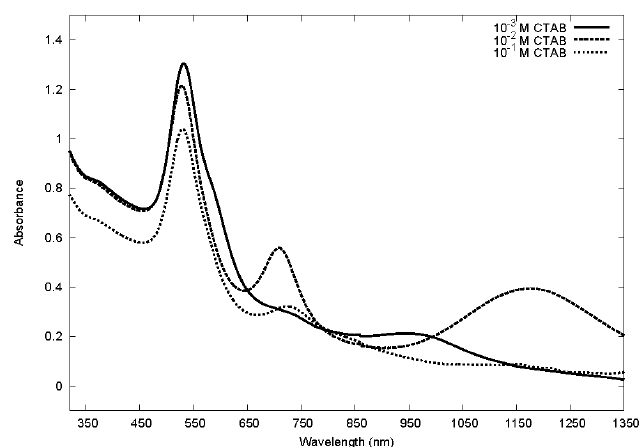
Fig. 1 UV/Vis spectra of solutions containing nanorods, prepared in the presence of 10 − 3 (solid line), 10 − 2 (dashed line), and 0.1 M (dotted line) CTAB,